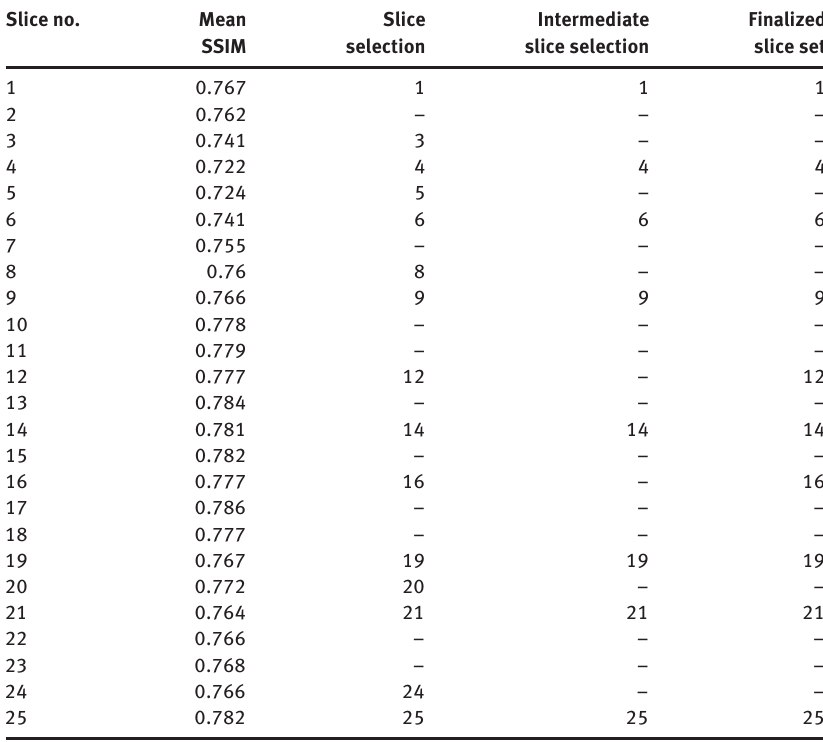
Table 1: Finalized slice selection based on SSIM. Slice no.